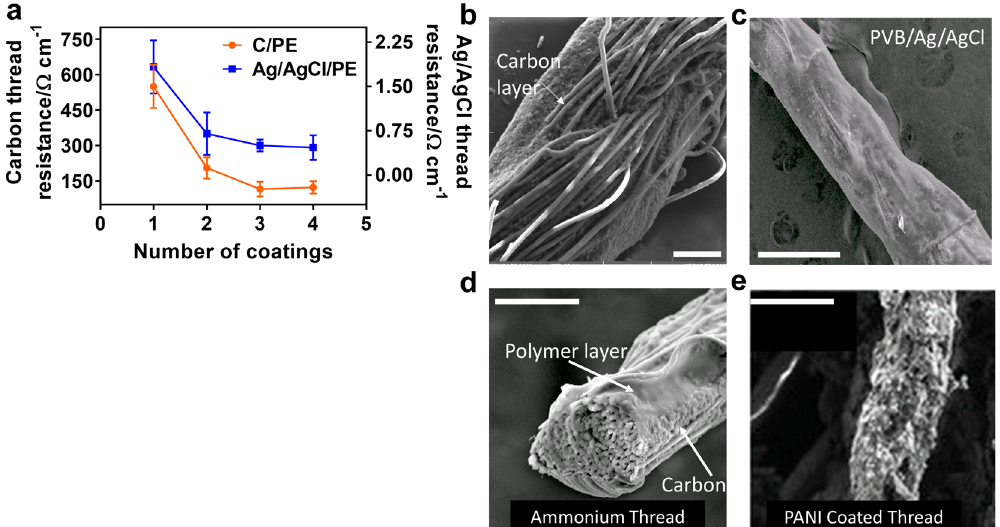
Fig. 3 Thread coatings characterization. a Electrical resistance ( Ω /cm) of conductive carbon ink coated PE threads (C/PE) and Ag/AgCl ink coated PE threads (Ag/AgCl/PE) after each coating cycle. Error bars from s.d. SEM images of b C/PE (scale bar 100 μ m), c PVB/Ag/AgCl/PE